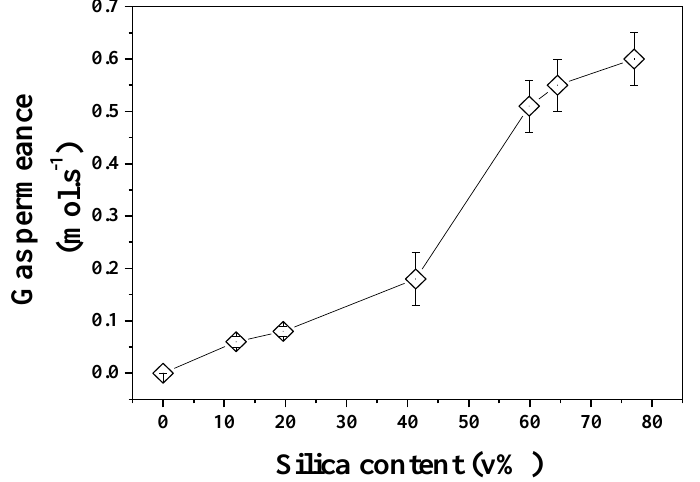
Figure 8. N 2 permeance across the etched Si-Ag NP